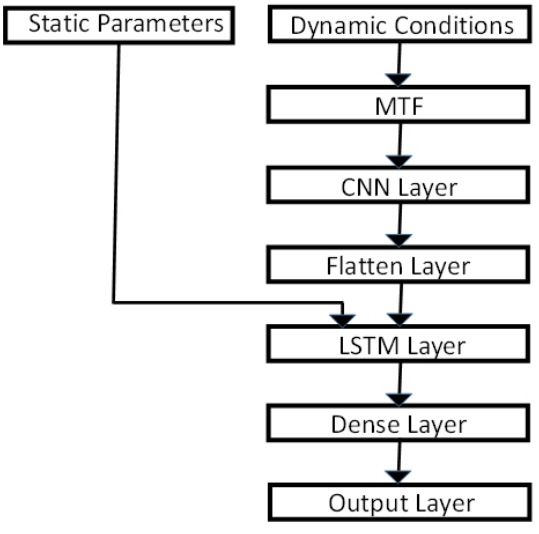
Figure 6. The framework of the proposed MTF-CLSTM